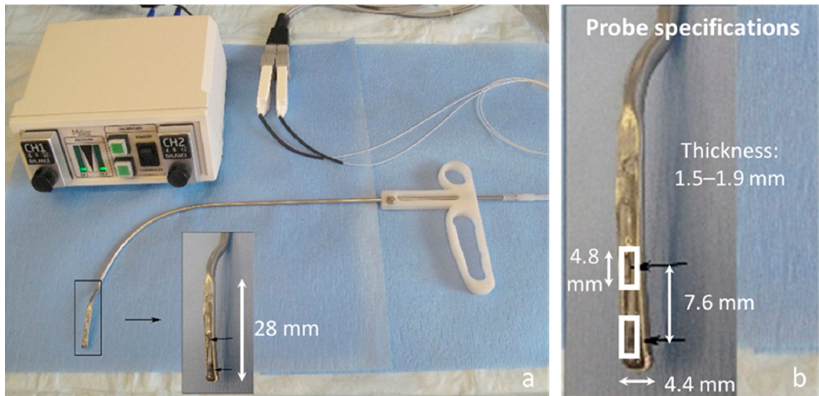
Figure 1. In vivo intraglottal/subglottal pressure (ISP) probe with inline, dual pressure sensors at the tip (arrows) for simultaneously measuring intraglottal and subglottal pressure during phonation. Shown are ( a ) the ISP probe with a Ford injector-like handle and two-channel signal conditioning electronics and ( b ) a zoomed-in view of the distal end of the ISP probe showing dimensions of the two inline pressure sensors embedded in epoxy.